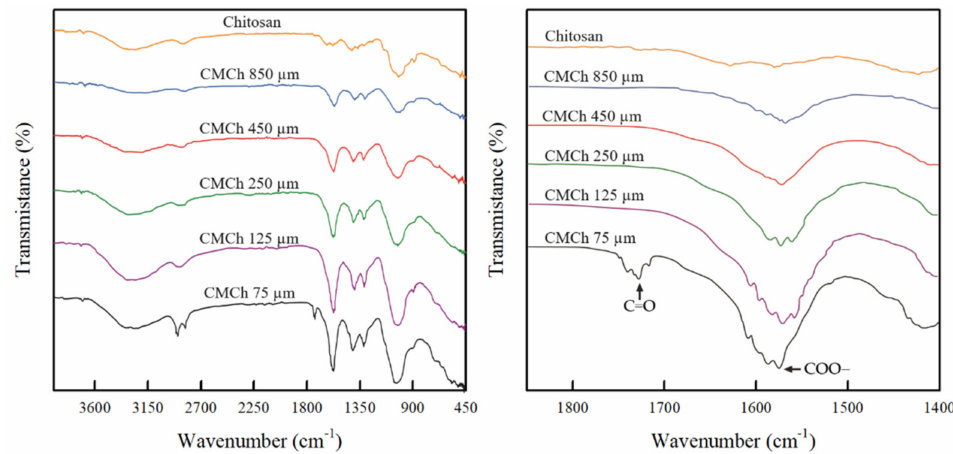
Figure 1. The FT − IR spectra of chitosan and CMCh powders prepared from chitosan with different particle